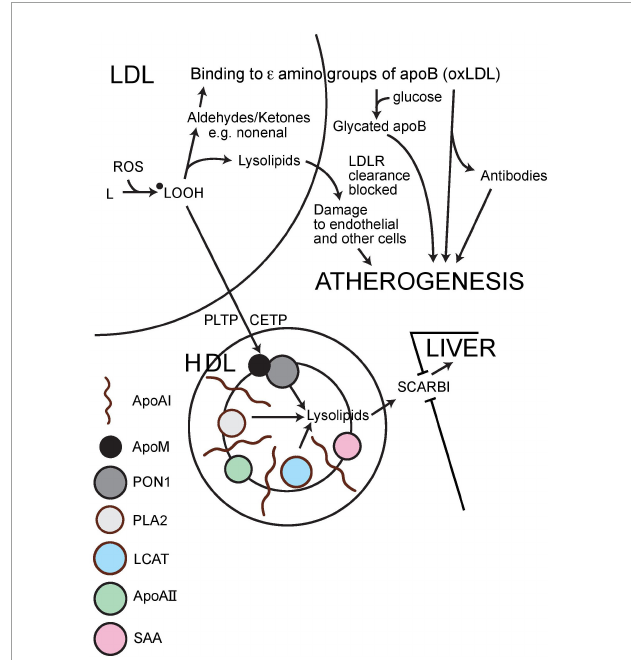
FIGURE4 Schematic representation of the mechanism by which HDL impedes the atherogenic modification of LDL. ApoA1, apolipoprotein AI; ApoAII, apolipoprotein AII; apoB, apolipoprotein B; ApoM, apolipoprotein M; PON1, paraoxonase 1; PLA2, phospholipase A2 (syn: PAFAH, platelet activating factor hydrolase); LCAT, lecithin cholesterol acyl transferase; SAA, serum amyloid A; PLTP, phospholipid transfer protein; CETP, cholesteryl ester transfer protein; SCARB1, scavenger receptor class B1; oxLDL, oxidatively modified LDL; LDLR, LDL receptor; L, lipid; • LOOH, hydroxylipid radical; ROS, reactive oxygen species (containing oxygen with an unpaired electron giving it an outer shell resembling